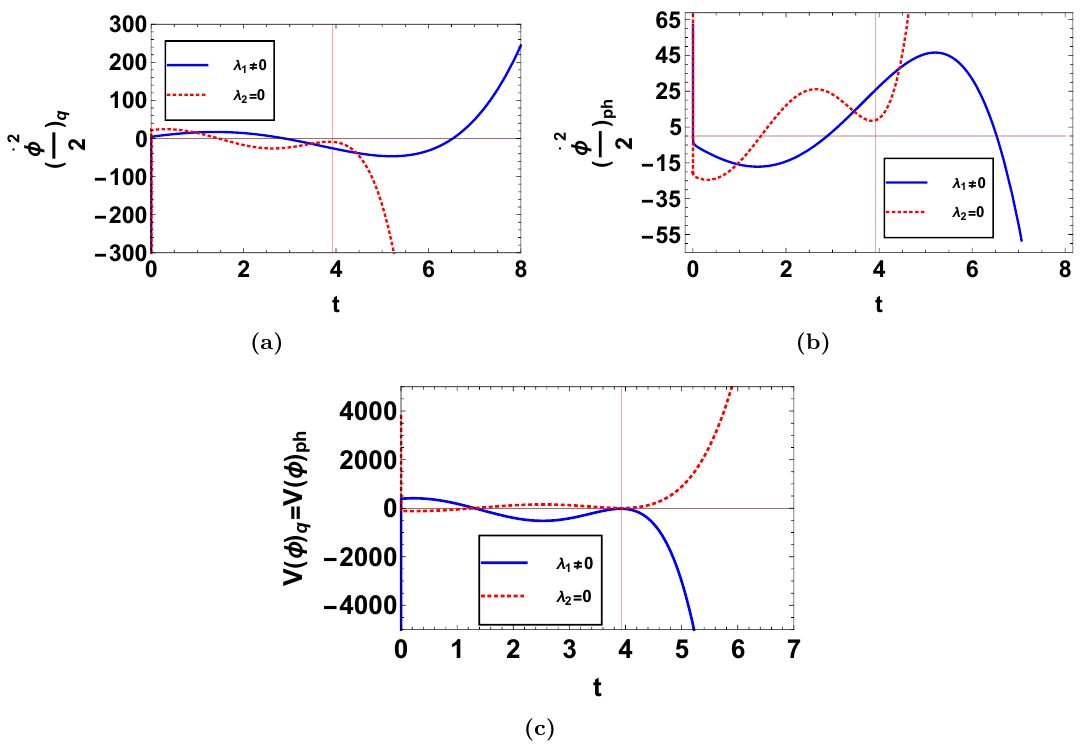
2 ˙ φ ) and the phantom- q 2